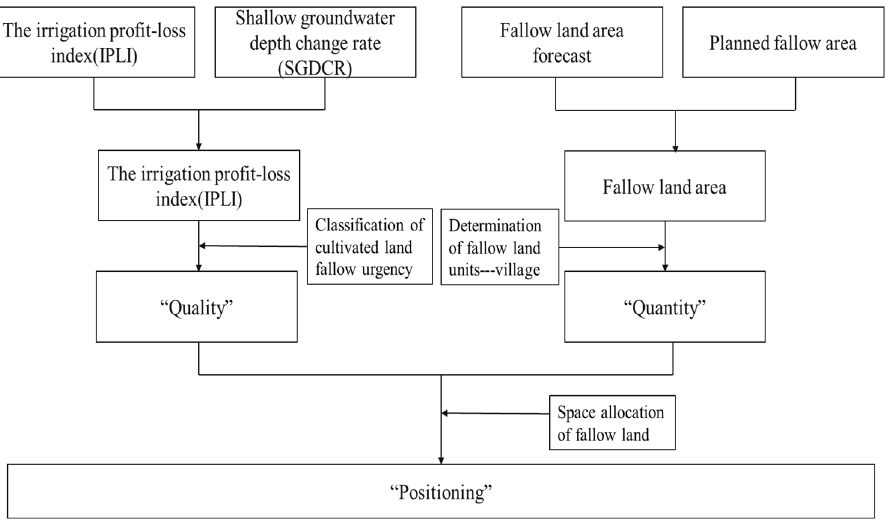
Figure 2. The overall framework of the study. First, the irrigation profit/loss index (IPLI) and the shallow groundwater depth change rate (SGDCR) are used to obtain the urgency of fallow cropland, which is divided into five levels to achieve the “quality” of the